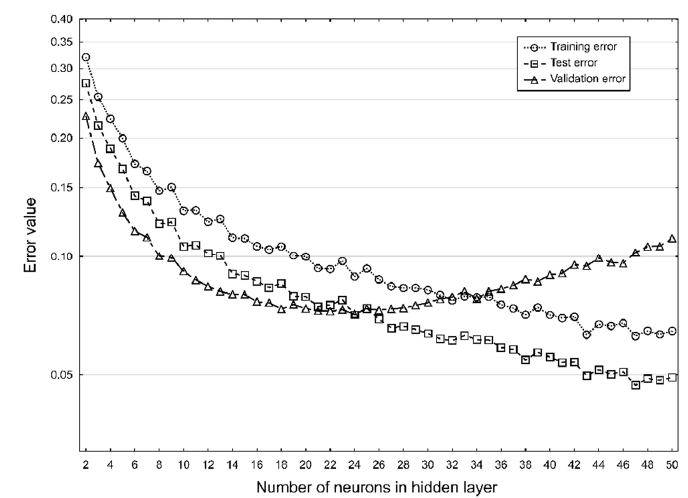
Figure 4. The effect of the number of neurons in the hidden layer on the mean values of training, test,